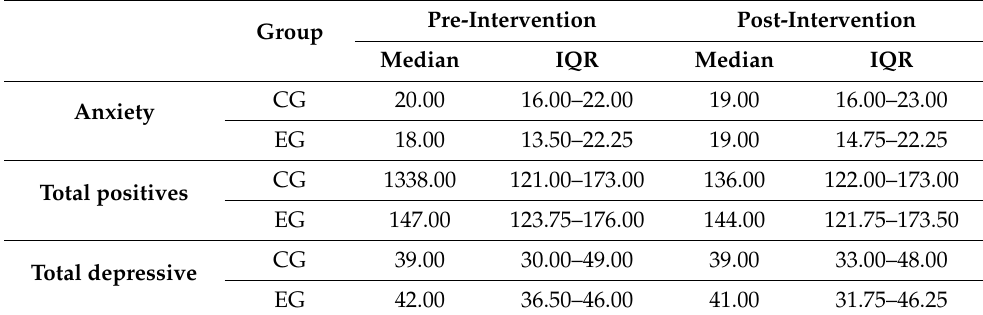
Table 2. Values of psychological variables according to the type of group, before and after performing the physical activity intervention. Pre-Intervention Post-Intervention Group Median